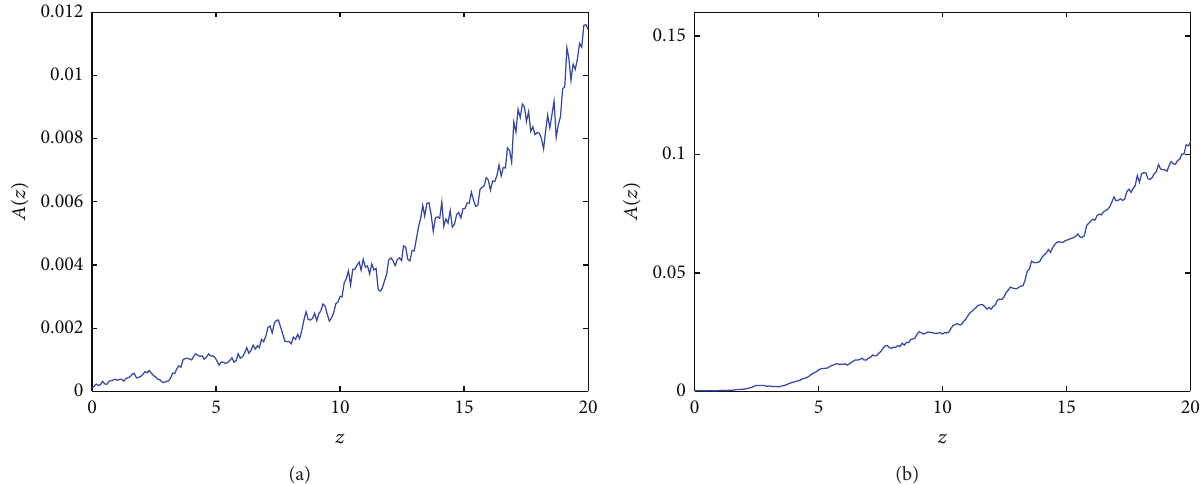
Figure 15: Linear evolution of the lattice soliton for the self-focusing cubic and the self-defocusing quintic model: peak amplitude 𝐴(𝑧) = max 𝑥,𝑦 |̃𝑢(𝑥,𝑦, 𝑧)| of the solitons as the function of 𝑧 , (a) for the first renormalization factor and (b) for the second renormalization factor.